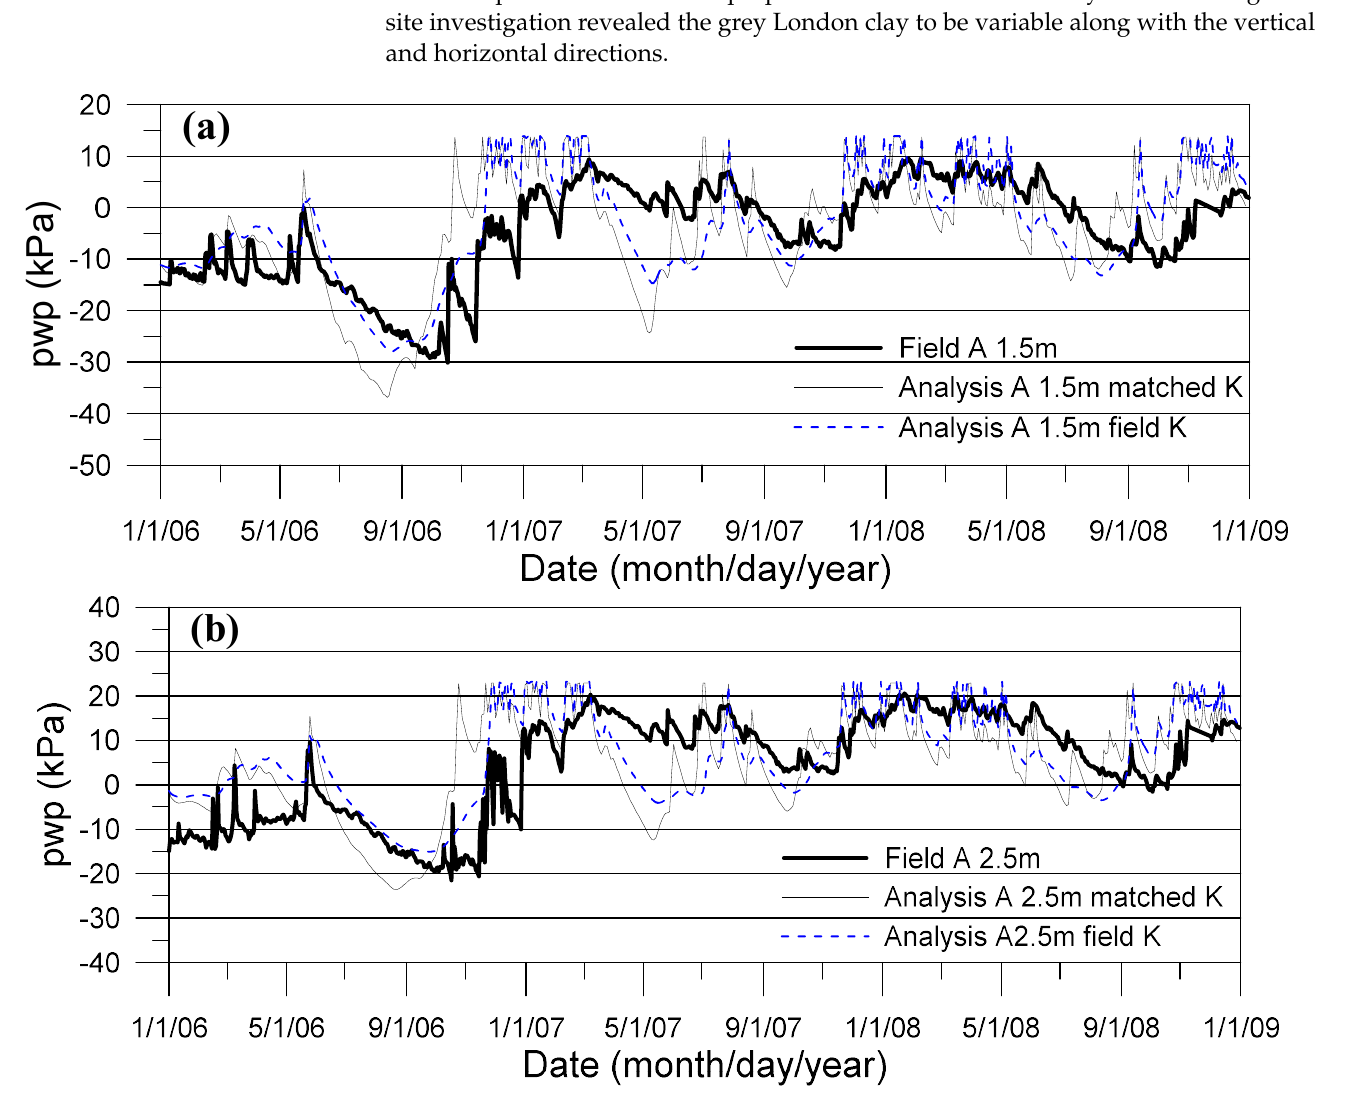
Figure 10. Field measured and calculated pore water pressure at ( a ) 1.5 m and ( b ) 2.5 m depths in section A.